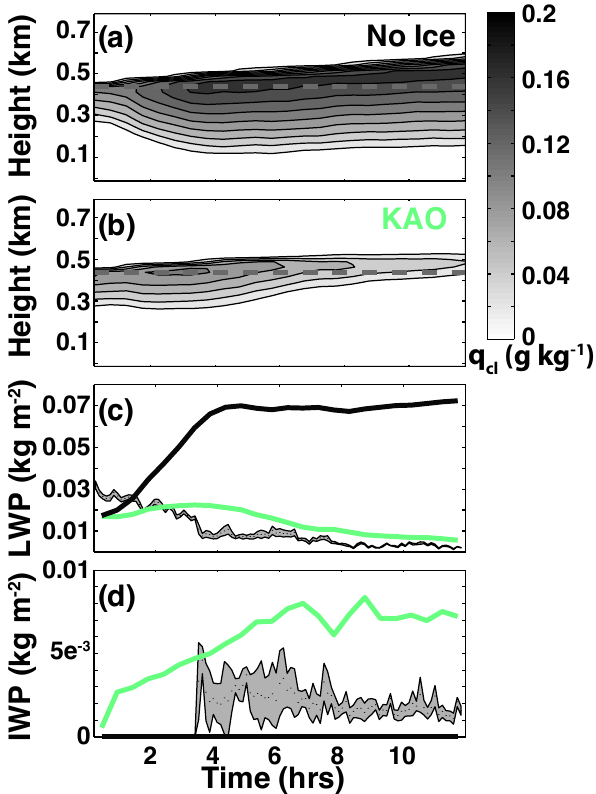
Fig. 3. Domain-averaged time-height cross-sections of cloud liq- uid water mixing ratio (gkg − 1 ) (a, b) and timeseries of domain- averaged liquid (c) and ice water paths (d) for the reference sim- ulations (NOICE, black and KAO, green). The dashed line on the mixing ratio figures is included to provide a reference height. Ob- served estimates for liquid and ice water path are shown in black dots (mean) and grey shading (standard